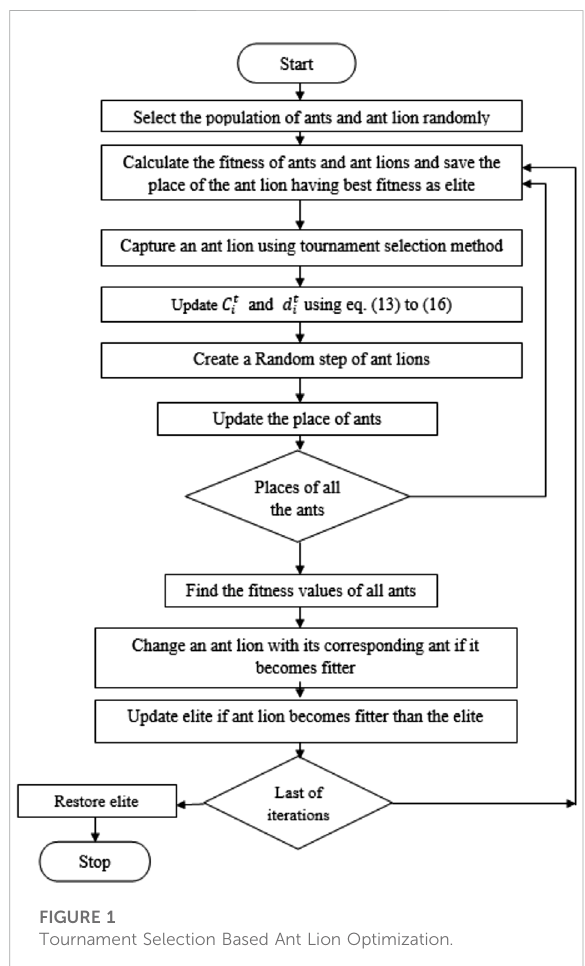
FIGURE 1 Tournament Selection Based Ant Lion